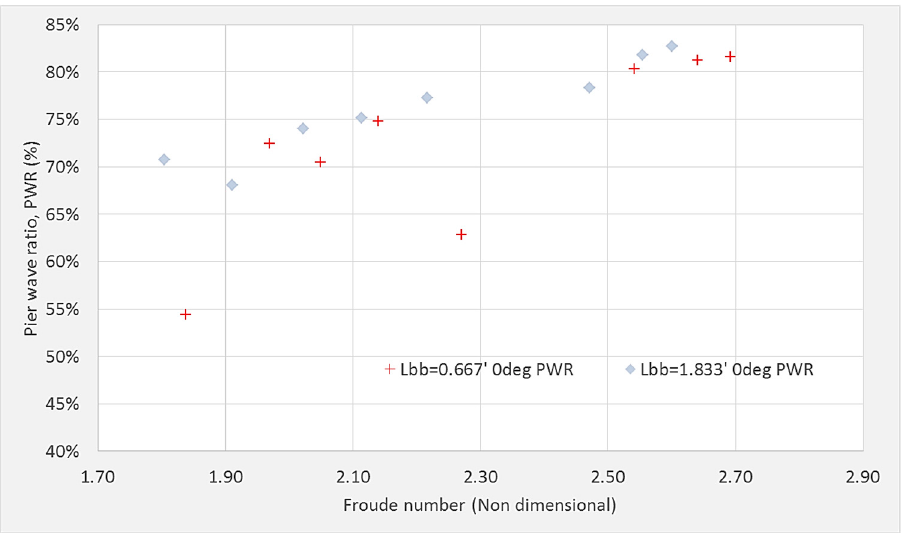
Figure 8. Bulbous pier spraying problem.